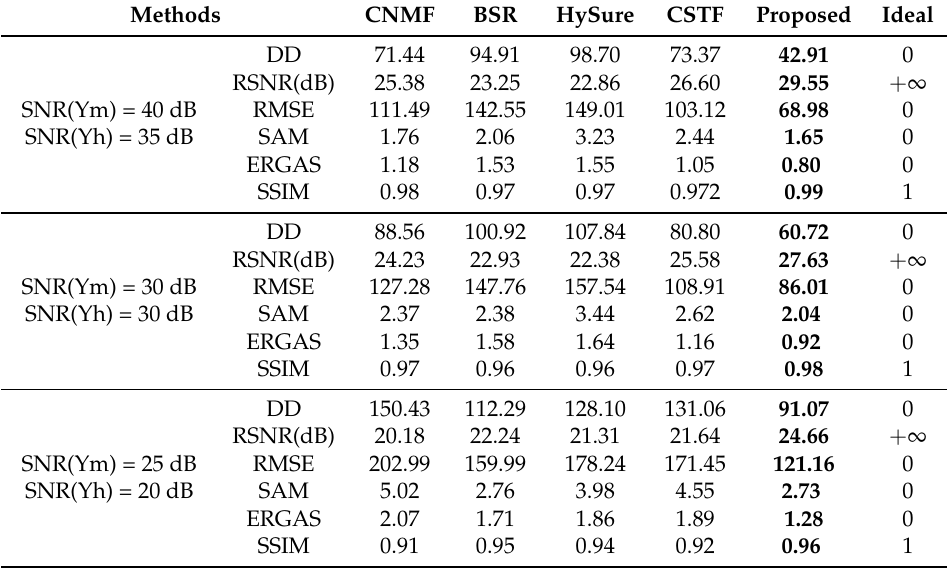
Table 3. Performance comparison of fusion algorithms for Moffett dataset (the boldface numbers denote the best